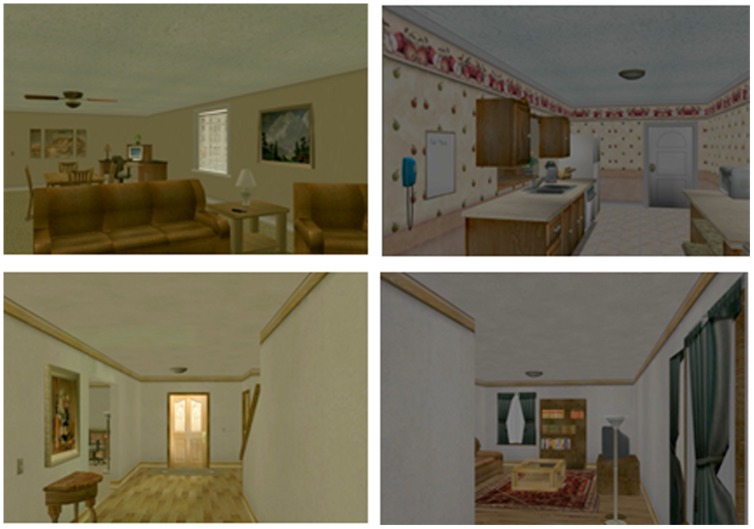
Examples of screenshots from the fear conditioning task. The upper two screenshots show the apartment with the light on and off. The lowest screen shots present the suburban house with the light on and off.